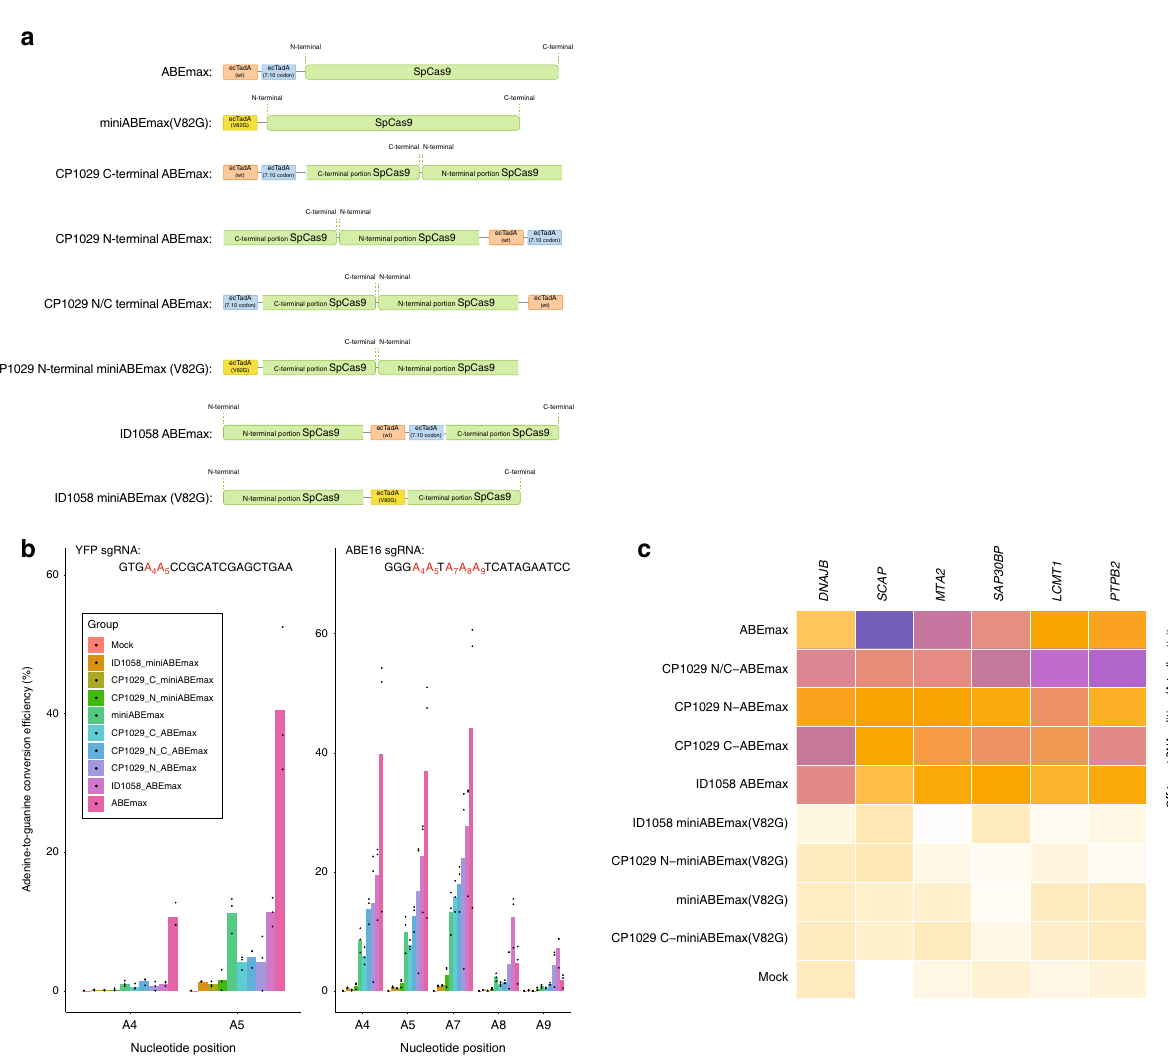
Fig. 2 Activity pro fi le of nSpCas9-adenine base editor (ABE) permutations. a The wild-type TadA and the evolved TadA monomer for ABEmax are light blue and orange stadiums, respectively, while the miniABEmaxV82G is depicted as a yellow stadium. b On-target activity pro fi le of different ABE permutants tested. nSpCas9-variants of ABE permutants were challenged against the YFP and ABE16 loci. Data are pooled from three independent technical replicates, showing the mean (colored bar) activity at several adenine positions measured for adenine-to-guanine editing. c Heatmap showing the off- target pro fi le of different permutations of nSpCas9 ABEs. Off-target events were considered at the position of the most heavily deaminated adenine in the promiscuous DNAJB, SCAP, MTA2, SAP30BP, LCMT1 , and PTPB2 transcripts (three independent technical replicates of three biological replicates targeting YFP , ABE16 , and non-targeting were included). Adenosine (A) to inosine (I) editing ef fi ciencies are shown as the mean value scaled from the lowest to highest value across all samples for all RNA off-target sites. Source data are available in the Source data fi